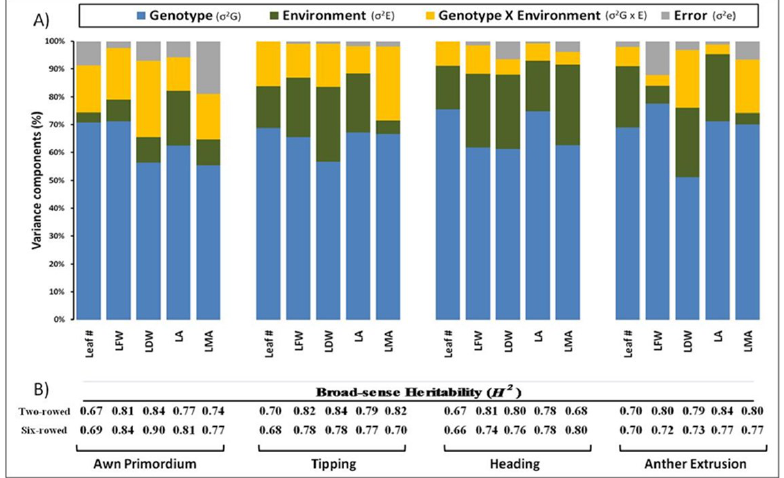
Figure 2. Variance components of leaf traits at different developmental stages in two- and six-rowed barley across all growth conditions ( A ) Broad-sense heritability of leaf traits at different developmental stages across all growth conditions in two- and six-rowed barley separately; ( B ) Leaf #: leaf number; LFW: leaf fresh weight; LDW: leaf dry weight; LA: leaf area; and LMA: leaf mass